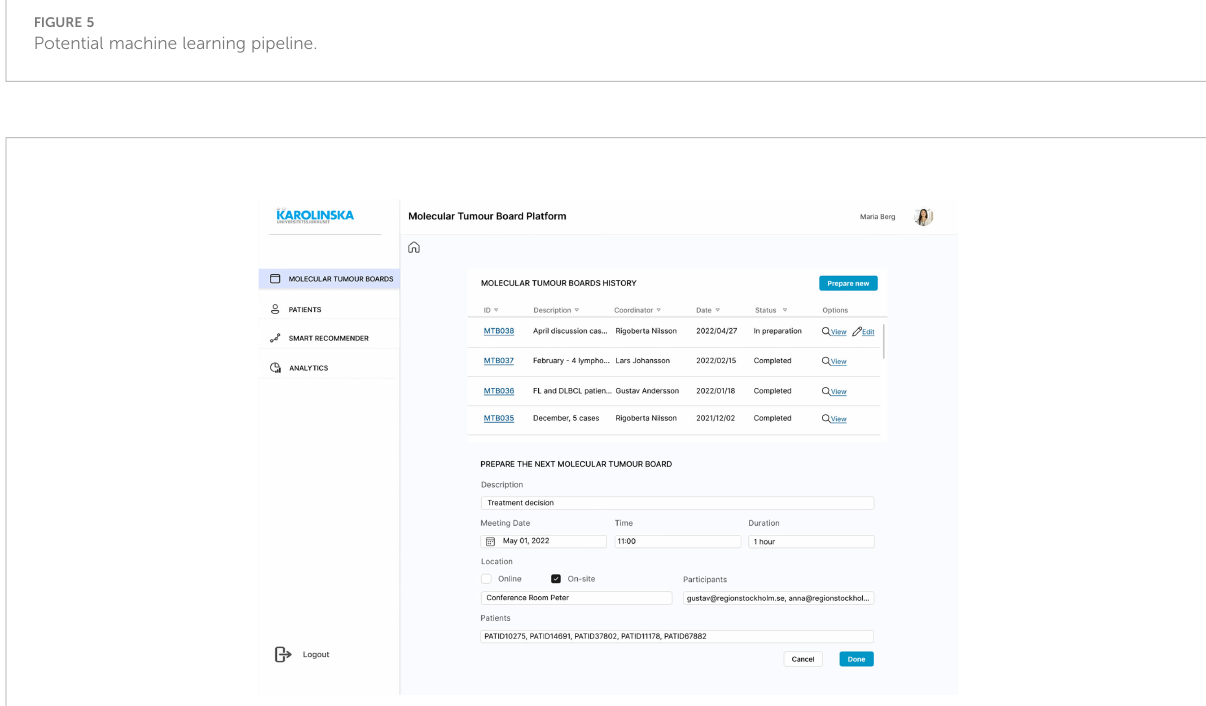
FIGURE 6 Mock-up screen. MTB history list and “ Prepare new ” form completed.